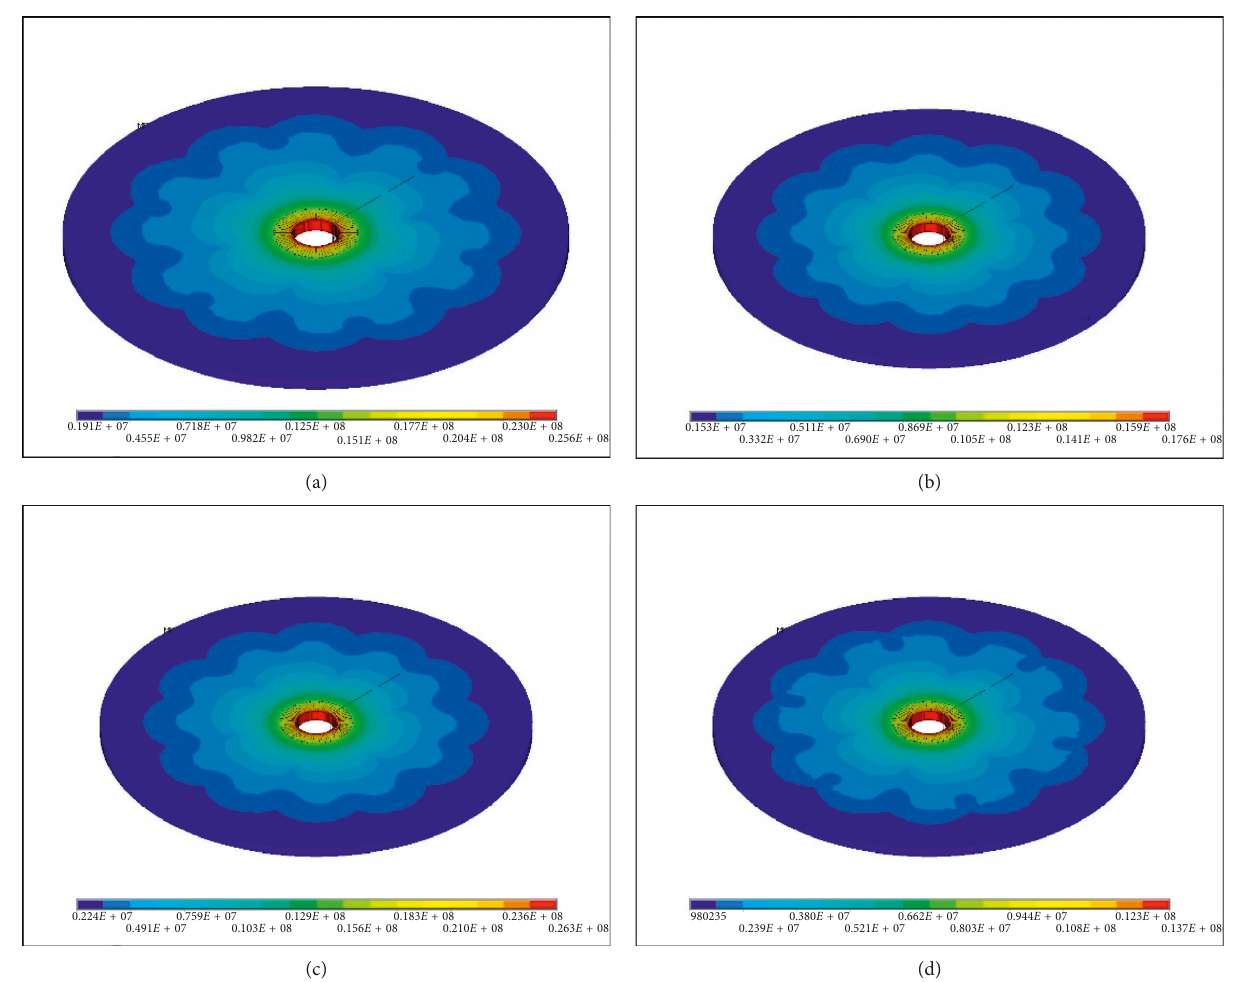
Figure 6: Mises stress distribution of the plate at different moments. (a) 1s. (b) 5 s. (c) 10 s. (d) 20s.